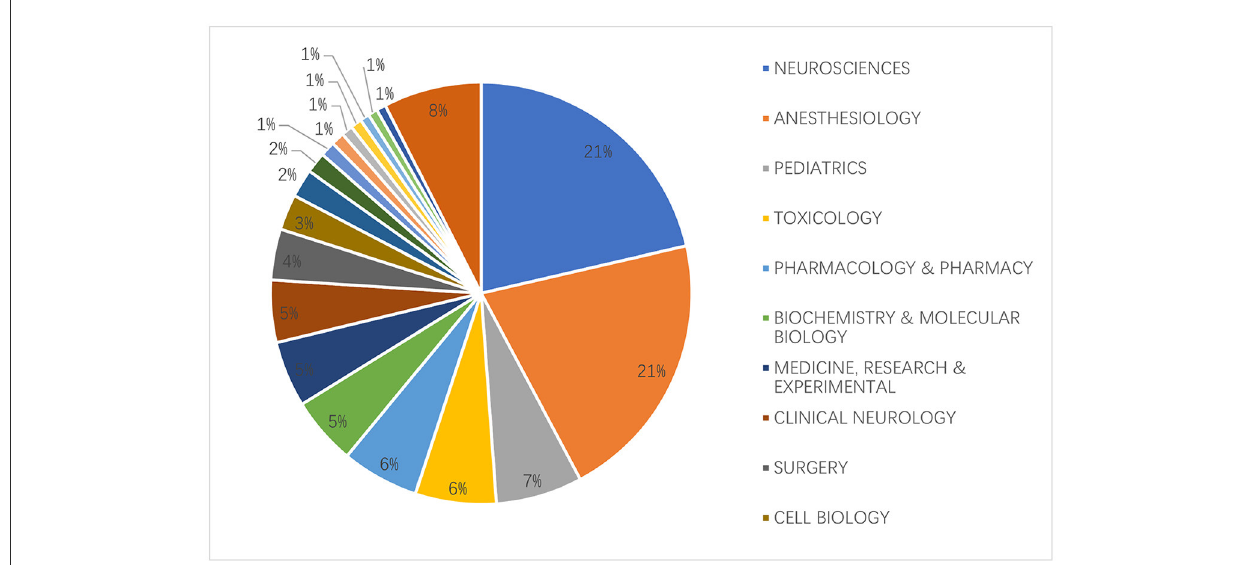
FIGURE5 The top 20 subjects related to the neurotoxicity of anesthesia in the developing brain are distributed.